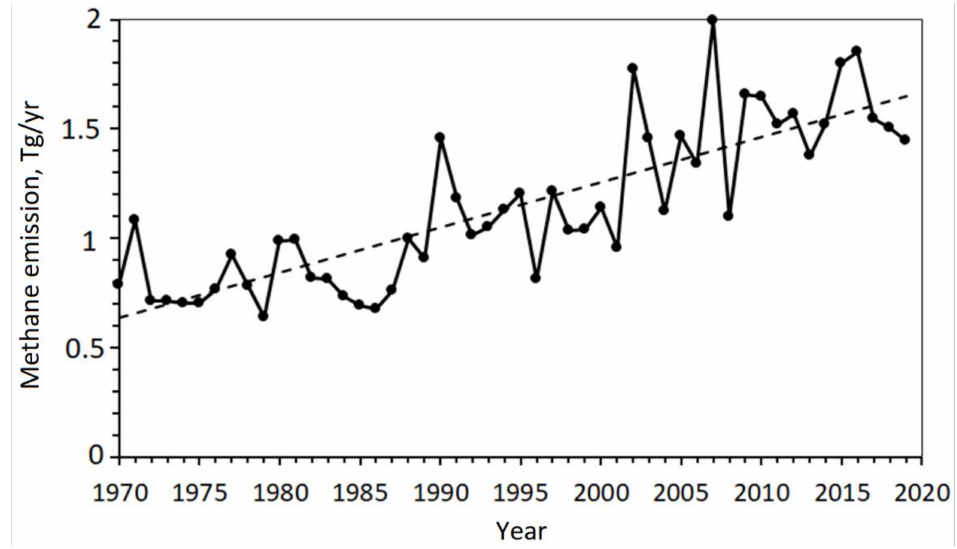
Figure 8. Annual average net sea–air methane exchange (Teragram per year) obtained in numerical experiment.